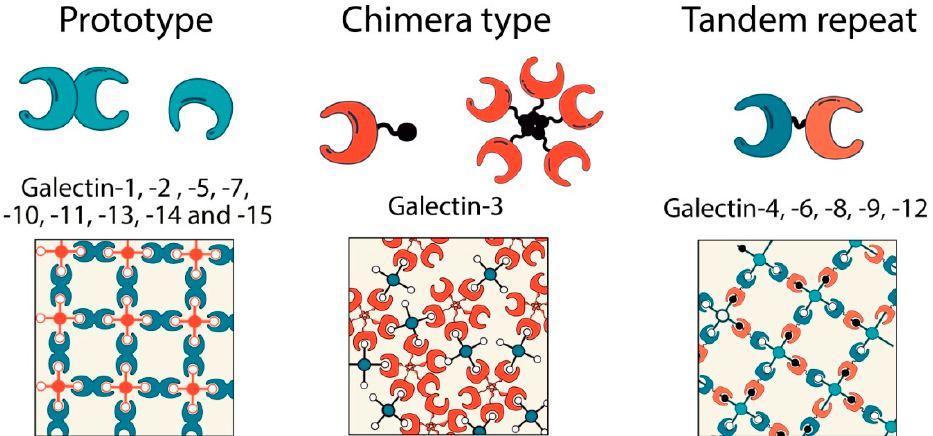
Figure 1. Schematic representation and structural classification of galectins. Galectin family mem- bers are subdivided into three groups proto-type galectins containing one carbohydrate-recognition domain (CRD) (including Gal1, Gal2, Gal3, Gal5, Gal7, Gal10, Gal11, Gal13, Gal14, and Gal15); galectin-3, a unique chimaera-type galectin consisting of repeats of proline- and glycine-rich short stretches fused onto the CRD; and tandem-repeat-type galectins (Gal4, Gal6, Gal8, Gal9, and Gal12), which contain two distinct CRDs connected by a linker of up to 70 amino acids. Lower panels represent hypothetical lattice formations of each group. Galectin’s bindings can be monovalent, biva- lent, or multivalent regarding their carbohydrate-binding activities: Proto-type one-CRD galectins often exist as dimers; galectin-3 undergoes conformational changes after binding multivalent lig- ands that enable its oligomerization as pentamers, and two-CRD tandem-repeat galectins have two carbohydrate-binding sites that form lattices with multivalent glycoconjugates.